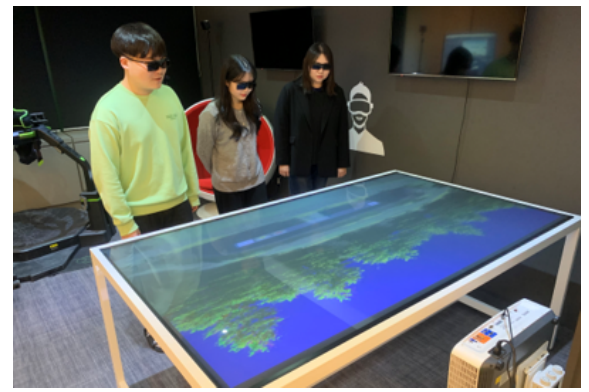
Figure 6. Projector